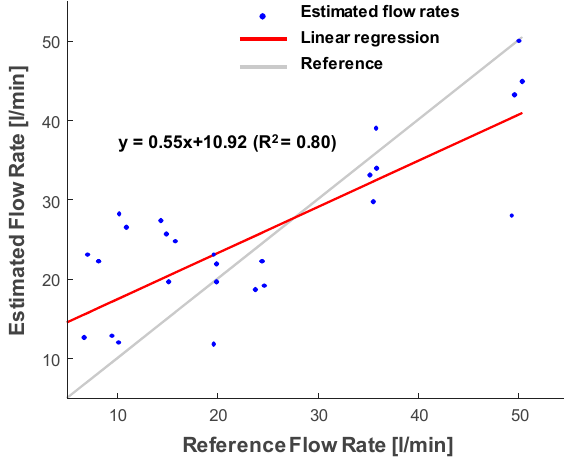
Figure 9. Estimated flow rates using the conventional zero-crossing method.